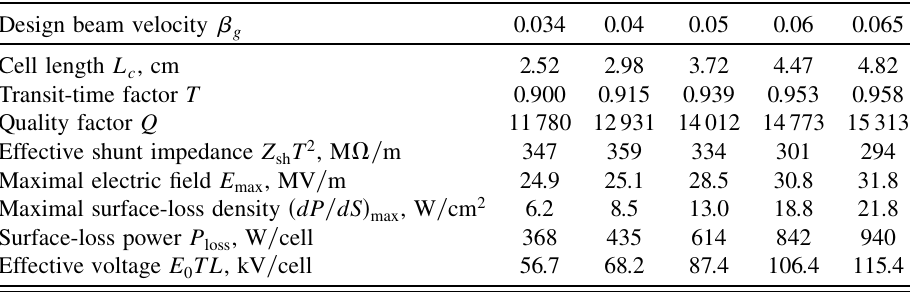
TABLE III. Characteristics of IH structures with vanes versus the design beam velocity. Design beam velocity (cid:1) g